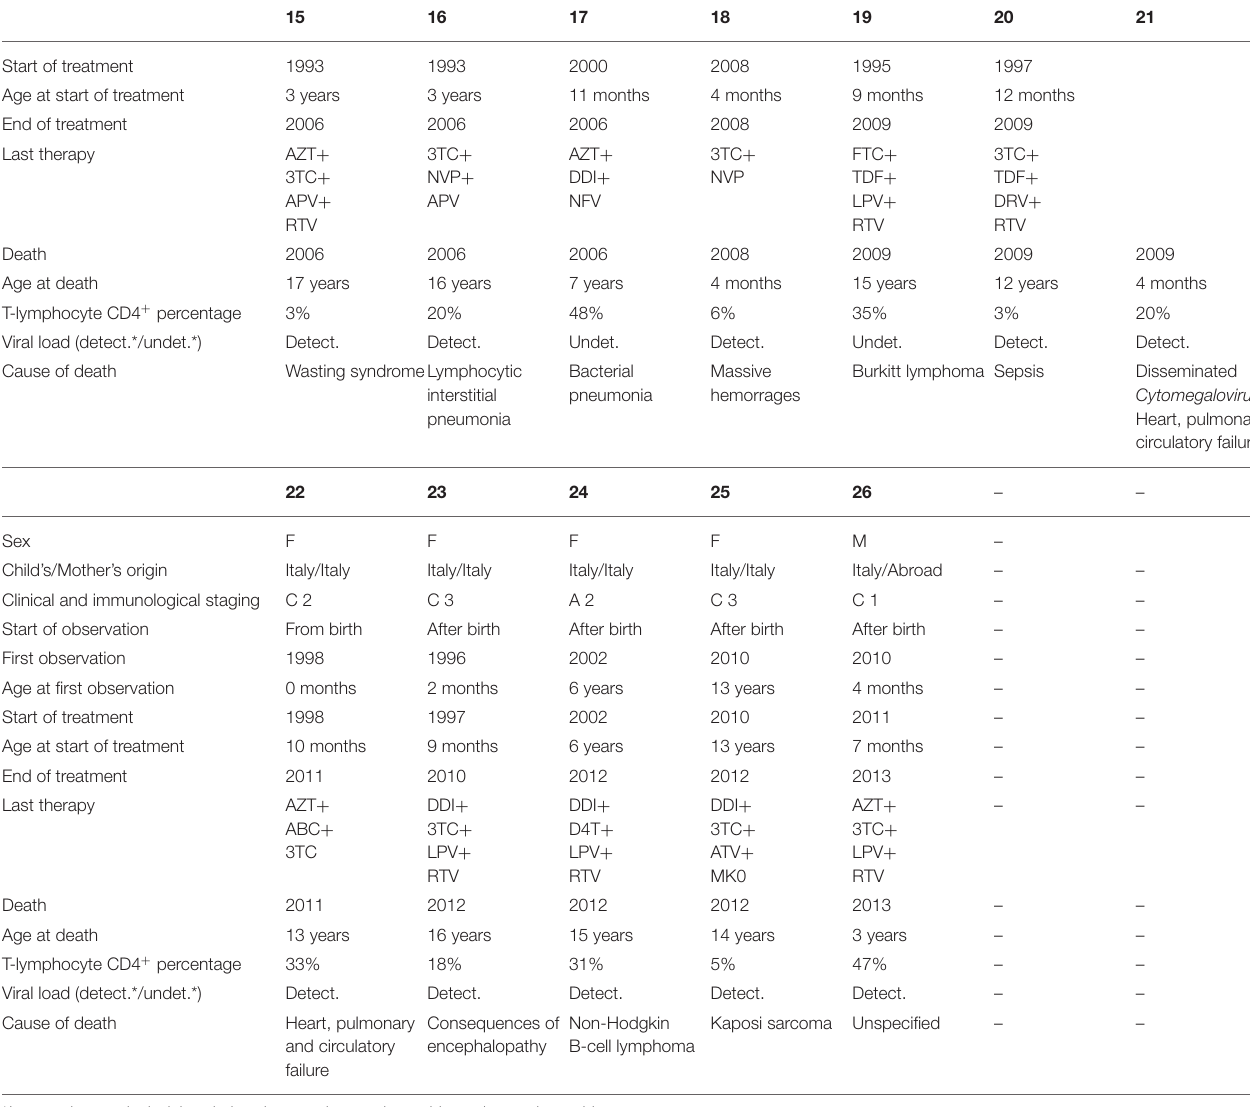
TABLE 4 | Centres for disease control and prevention class B and C clinical events in HIV-1 infected children by calendar period. Event class and calendar period